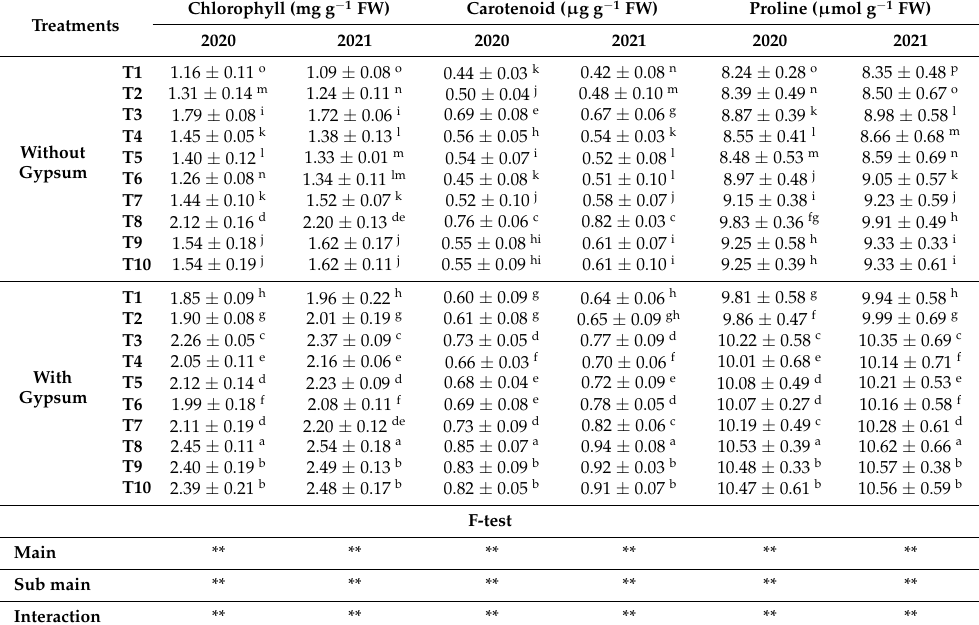
According to the Duncan’s test, means denoted by various letters show significant differences between treatments ( p ≤ 0.05). Values are the means standard deviations (SD) of three replicates. T1 : without PGPR + 0 mg L −